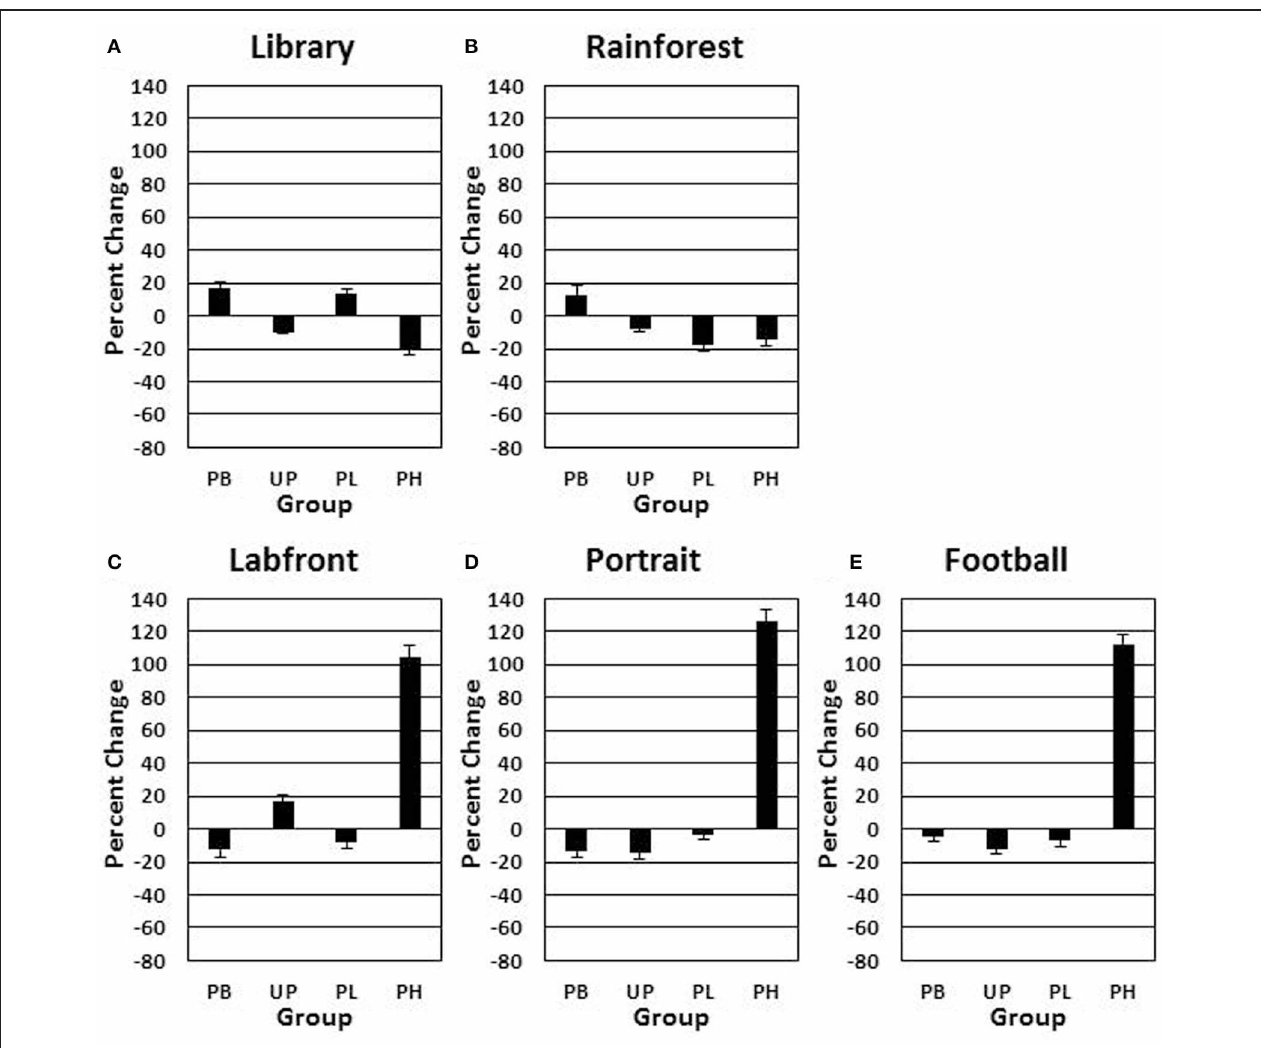
FIGURE 4 | Conditioned contextual facilitation of positive affect during the Association phase for four experimental groups. Shown is the degree of contextual facilitation (% change from Association day 1 to Test day 4) of positive affect ratings induced by 5 video clips [